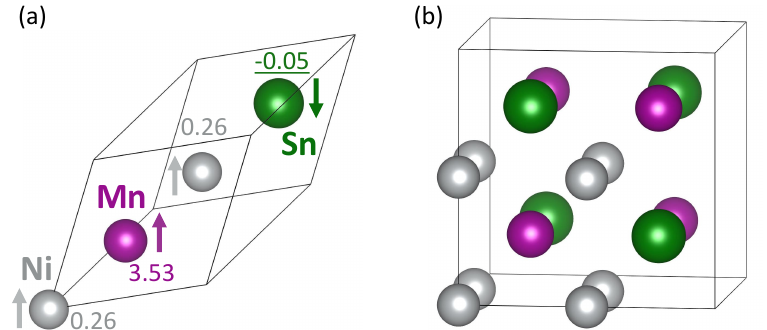
Figure 1. Schematic visualizations of 4-atom rhombohedral primitive unit cell ( a ) and 16-atom computational supercell ( b ) of the stoichiometric Ni 2 MnSn with the austenitic structure (L2 1 , so- called full Heusler structure). Arrows in part ( a ) indicate the orientation of local magnetic moments and numbers accompanying them are their magnitudes in Bohr magnetons with negative values indicating an antiparallel orientation (also underlined for the sake of